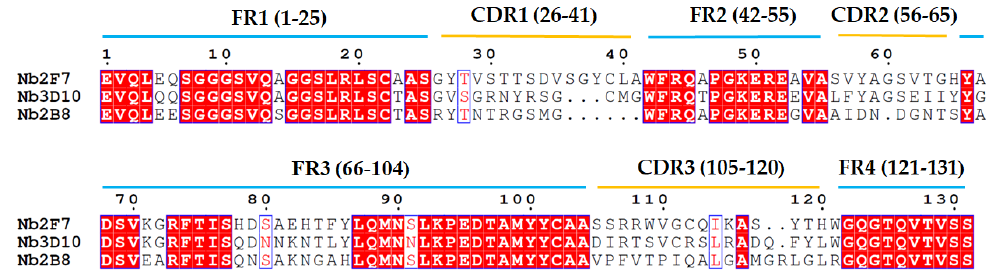
Figure 3. Sequence alignment of three positive clones.